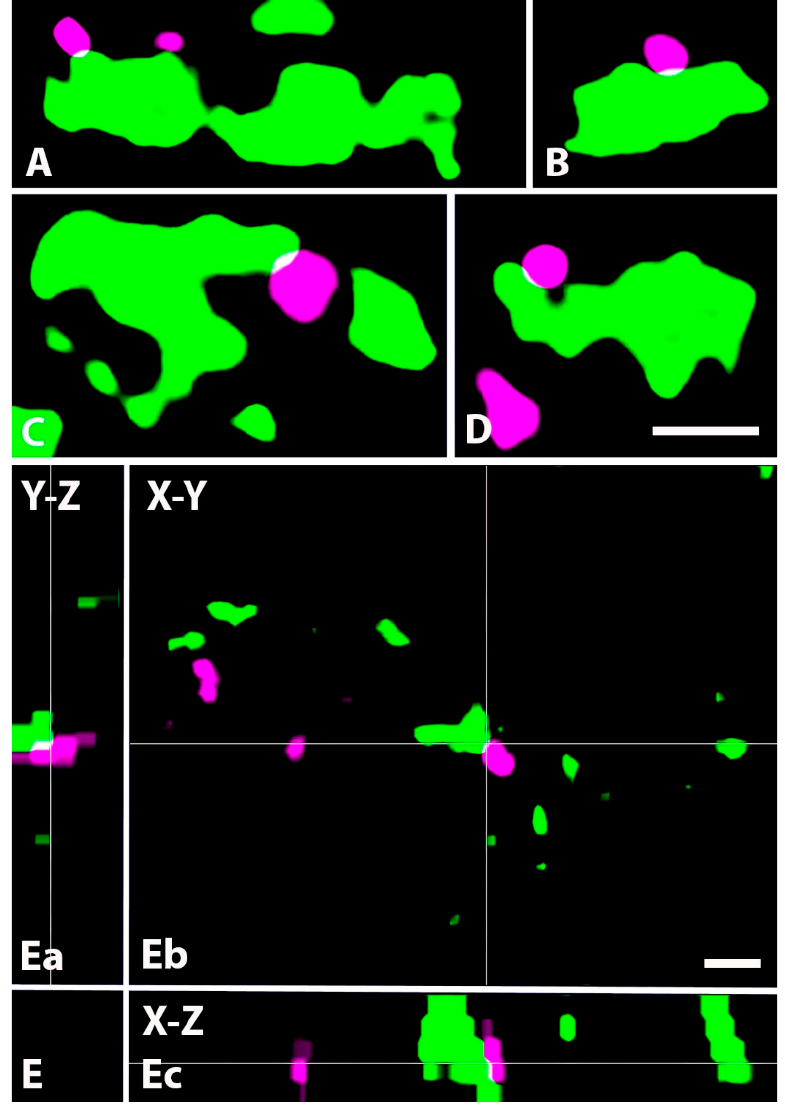
Figure 9. Close appositions between axon terminals immunoreactive for GlyT2 and binding IB4. ( A – D ). Micrographs of 1 µ m thick laser scanning confocal optical sections showing close appositions between axon terminals immunoreactive for GlyT2 (magenta) and binding IB4 (green), a marker for nonpeptidergic nociceptive primary afferents. Note the thin contact zone (yellow) between the two types of labeled axon terminals, which may represent axo-axonic synapses observed with electron microscopy. ( E ). Micrographs of a short series of confocal optical sections double labeled for GlyT2 (magenta) and IB4-binding (green) showing contact between GlyT2 immunoreactive (magenta) and IB4 binding (green) axon terminals shown in X-Y (Eb), X-Z (Ea) and Y-Z (Ec) projections. The contact zone between the two labeled axon terminals is at the crossing point of two lines indicating the planes through which orthogonal views of X-Z and Y-Z projections were drawn. Note that the contact zone between the two labeled axon terminals (yellow) can be identified in all three orthogonal images. Scale bars: 0.5 µ m ( A – D ), 1 µ m ( E